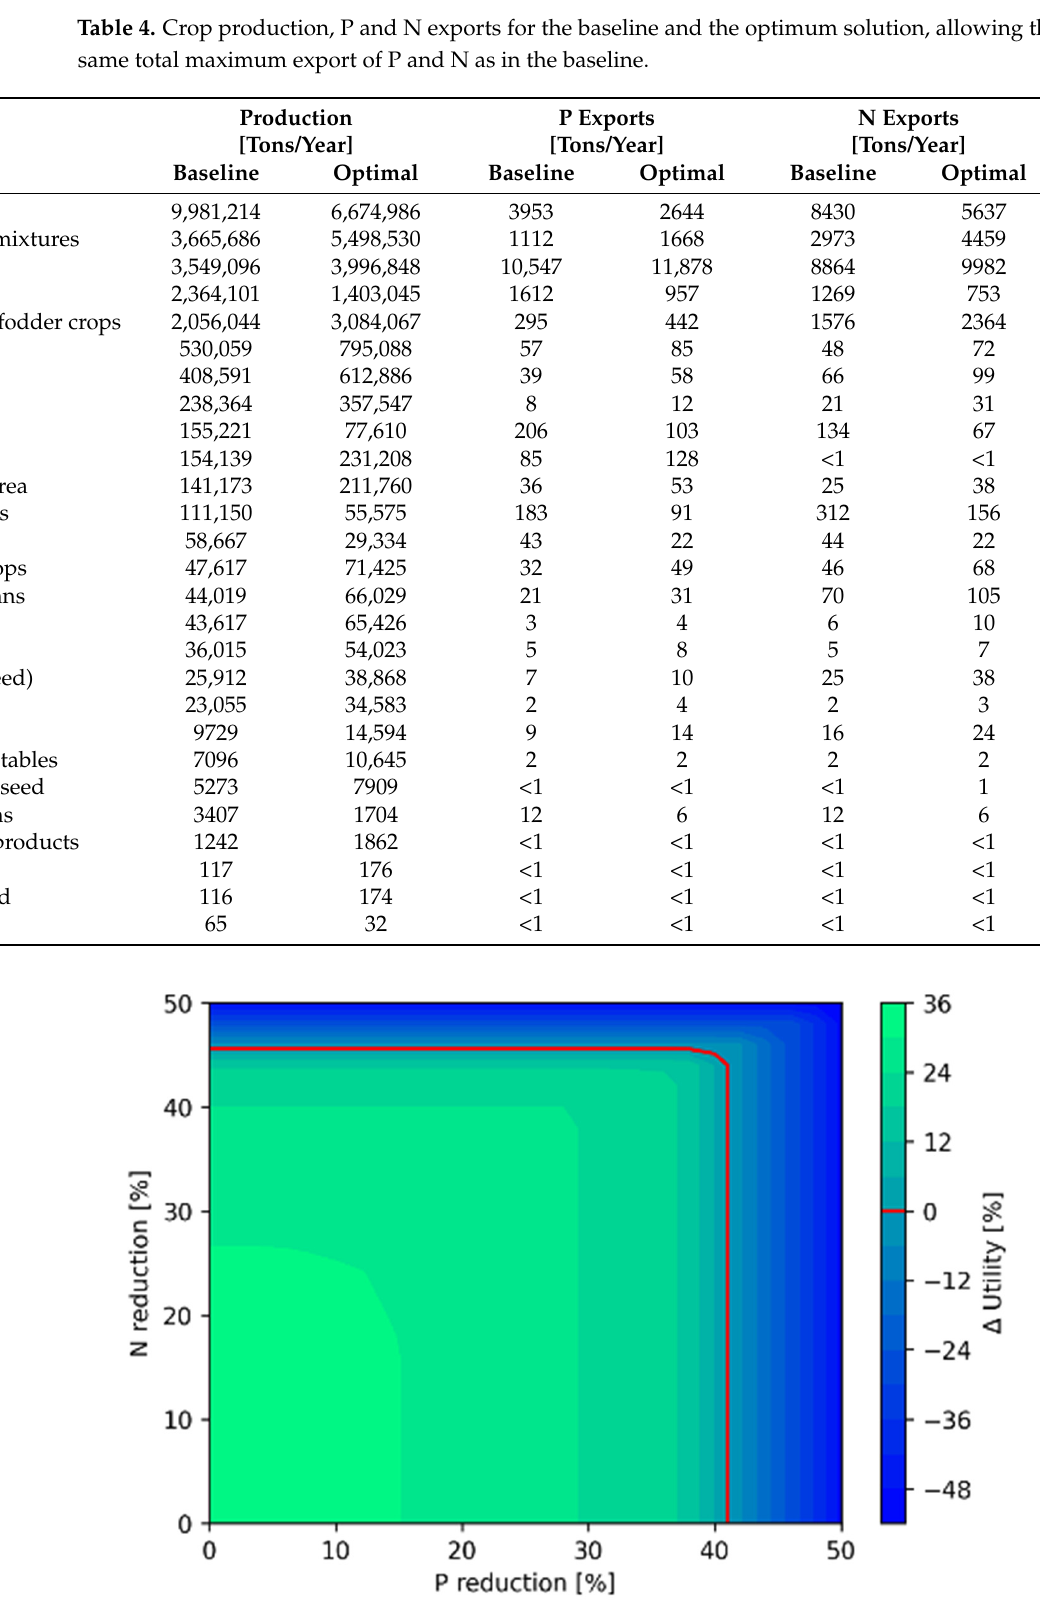
Figure 3. Change of profits in agriculture ( ∆ utility) from the baseline for varying P or N reductions using the model’s version 1. The red line shows the contour where the utility is the same as in the baseline.